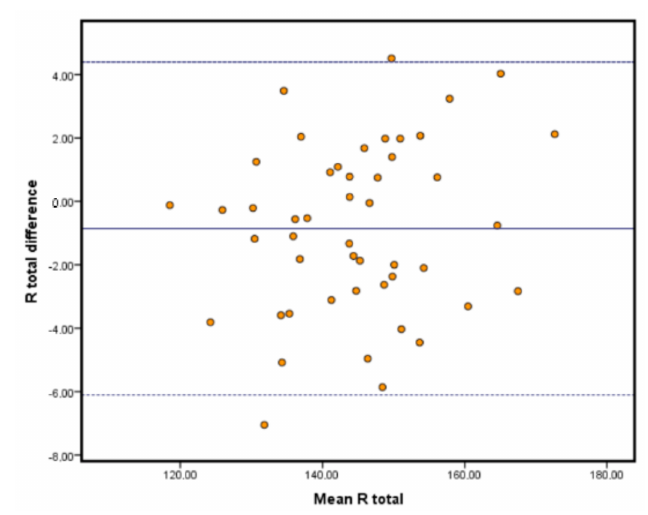
Figure 5. Bland-Altman plot lateral bending ROM.